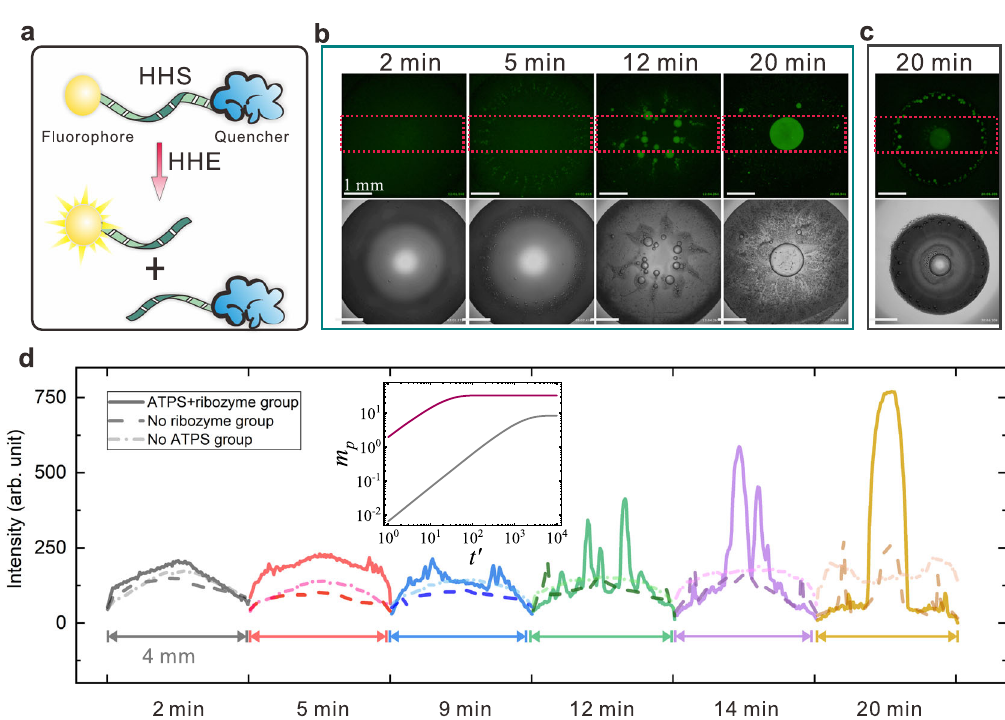
Fig. 5 Enhanced ribozyme cleavage by compartmentalization. a Schematic drawing of the RNA cleavage reaction. The fl uorophore labeled hammerhead substrate (HHS) is cut into two smaller pieces by the hammerhead ribozyme (HHE) and emits green fl uorescence. The substrate contains a donor that is quenched by FRET when HHS is not cleavage. b Image sequence shows RNA cleavage process inside the phase-separated compartments. c Control group of the RNA cleavage reaction inside an evaporating droplet while without HHE added. There is only fl uorophore labeled substrate (HHS) introduced into the droplets. d Fluorescence intensity evolution of experimental group (both HHS and HHE are introduced into the evaporating ATPS droplet; Solid line), no ribozyme control group (only HHE is introduced into the evaporating ATPS droplet; Dashed line) as well as no ATPS control group (both HHS and HHE are introduced into the evaporating water droplet; Dash-dotted line). The intensity value is obtained by gel analysis of a speci fi ed rectangular area (as shown in ( b ) and ( c )) in the fl uorescence images. Images are obtained over analysis of three independent trials with relative humidity ranging from 55 to 65%. Insert: Dimensionless productivities m p of ribozyme cleavage in the domain of dextran-rich compartment (red solid line) and that of water droplet (gray solid line) as a function of dimensionless time t 0 . Source data are provided as a Source Data fi le. The scale bar is 1